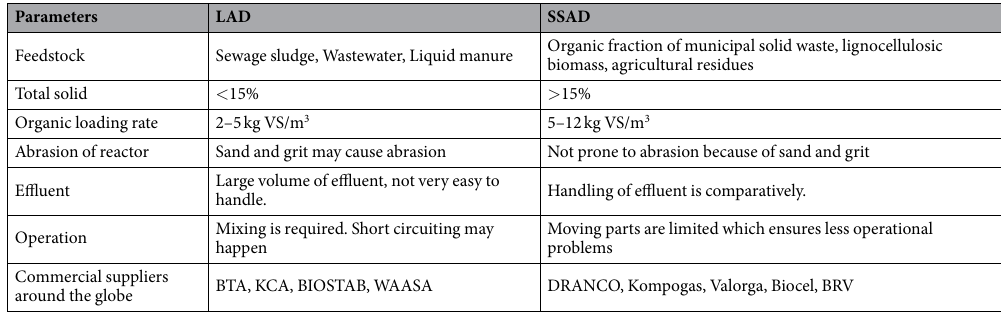
Table 1. Comparison of solid and liquid state anaerobic